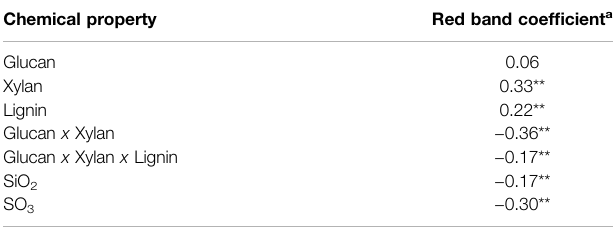
TABLE3| Chemicalproperties,includingselectashspecies(SO 3 andSiO 2 ),were used to form linear regressions to explain the red-band